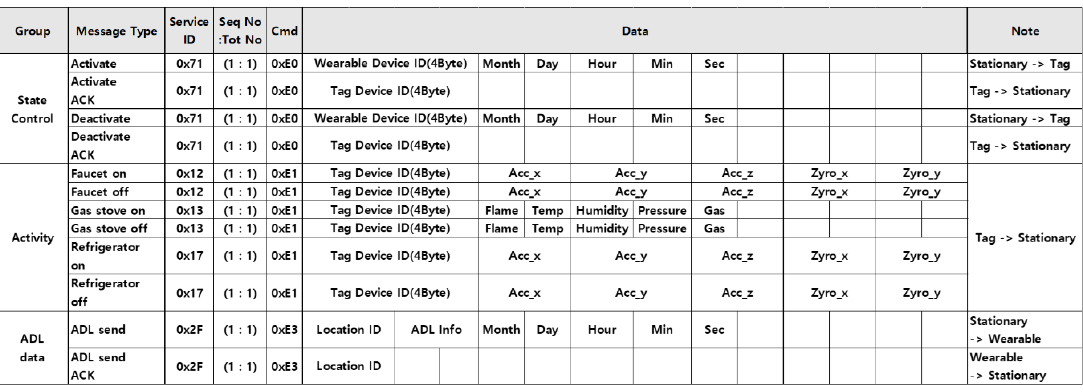
Figure 3. Communication protocol between the wearable, tag, and stationary devices.